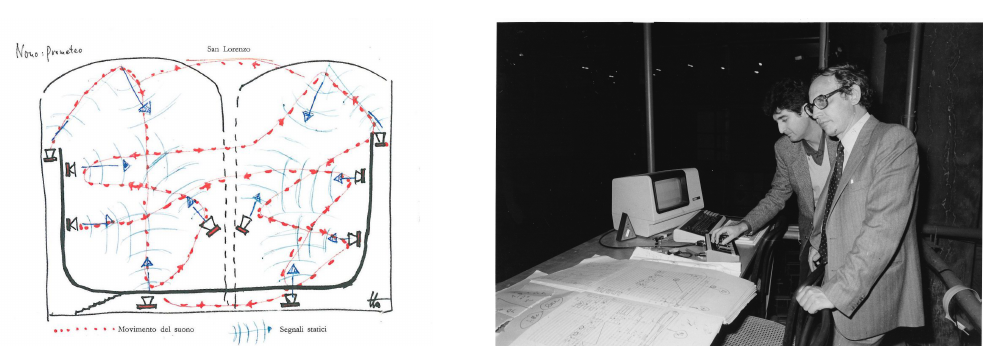
Figure 19. Prometeo, tragedia dell’ascolto by Luigi Nono. Sound movements inside the wooden resonating structure: as drawn by Hans Peter Haller, sound director ( left ). Alvise Vidolin (live electronics performer) and Giuseppe Di Giugno (designer of 4i System) during the rehearsal in Venice in 1984 ( right